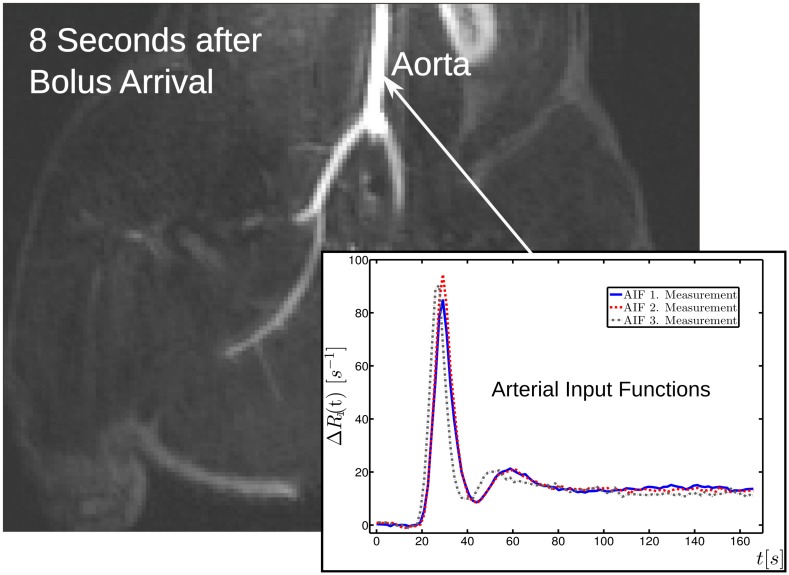
Coronal image of a dynamic GRE scan.Coronal image of a dynamic GRE scan obtained eight seconds after bolus arrival. Also shown are examples of the three arterial input function measurements in the abdominal aorta.